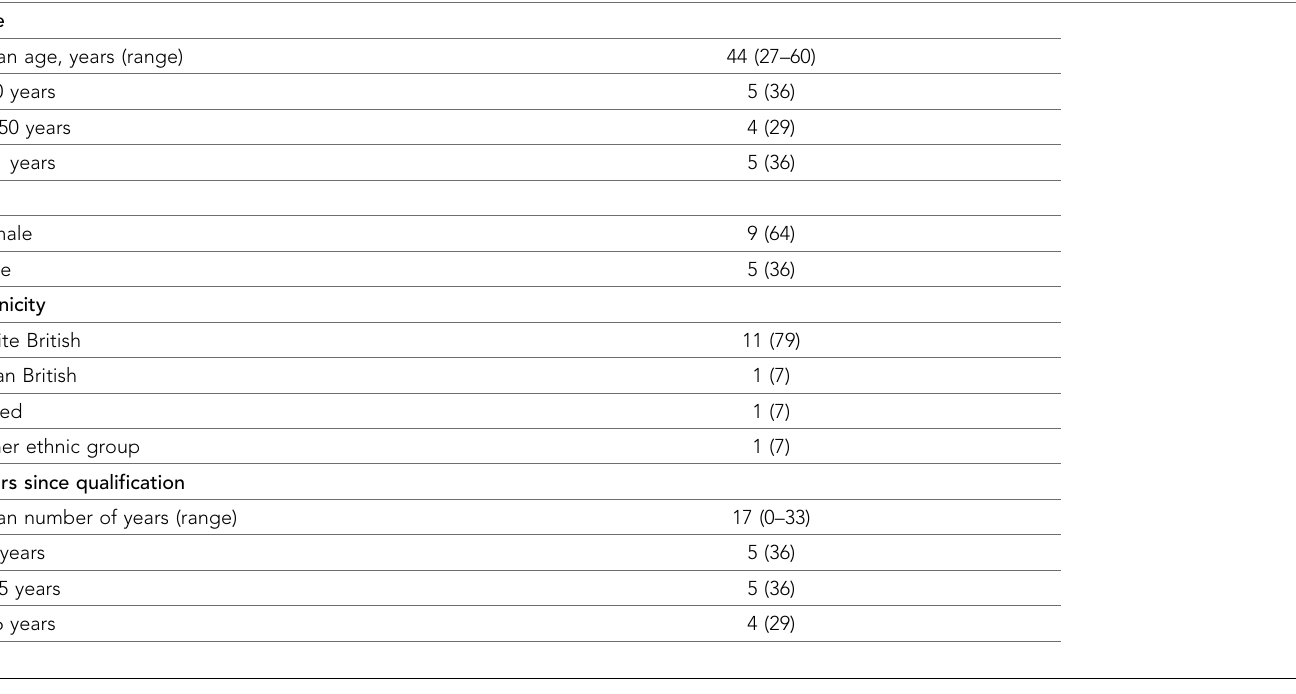
Table 1A Characteristics of the participant GPs ( n =